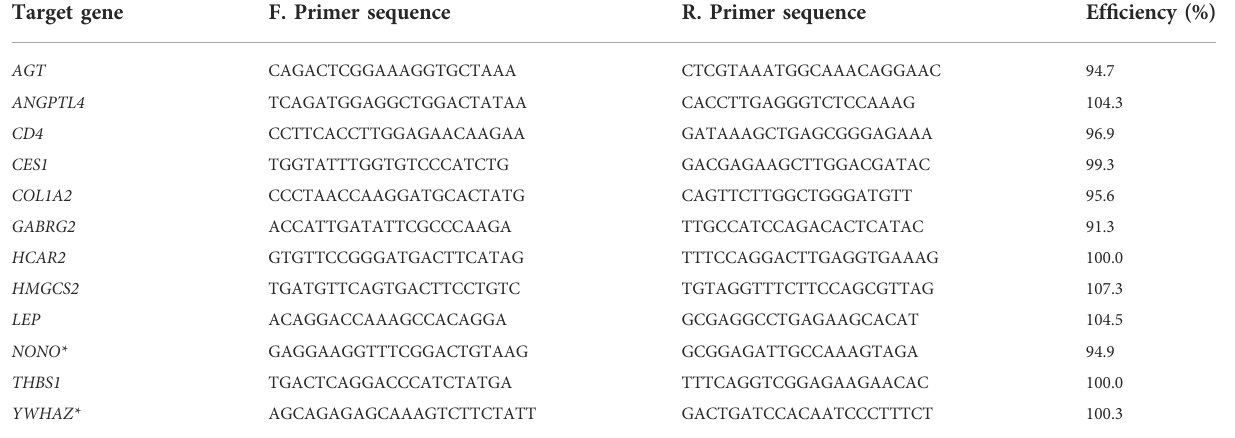
TABLE 1 Sequences and ampli fi cation ef fi ciencies of primers used in the study. Target